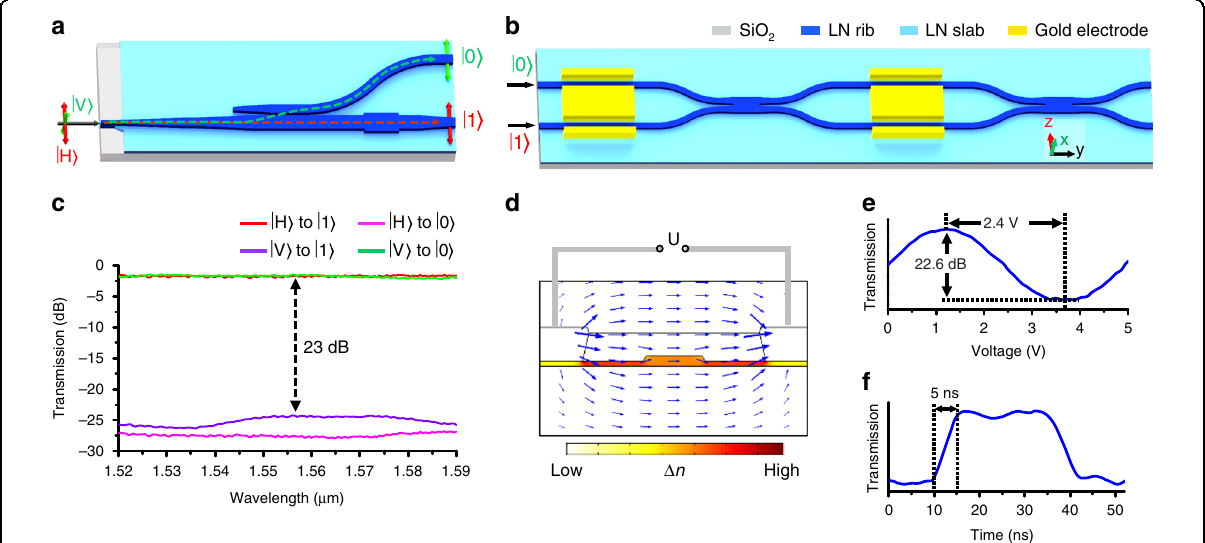
Fig. 1 Architecture and performance of the fundamental building blocks. a The schematics of the polarization splitter and rotator (PSR). V j i and H j i represent the vertically and horizontally polarized components of light in free space, respectively. 0 j i and 1 j i represent fundamental TE modes of upper and lower waveguides, respectively. b The architecture of 2 × 2 Mach-Zehnder interferometer (MZI), composed of two electro-optic (EO) phase shifters. c The measured transmissions of the fabricated PSR (including the off-chip coupling loss) when injecting horizontal polarization H j i and vertical polarization V j i , respectively. d The numerical result of the refractive index variation distribution of the lithium niobate (LN) waveguide when applying the voltage to the electrode. e The normalized transmission of a MZI as a function of an applied voltage, showing a half-wave voltage of 2.4 V and an extinction ratio of 22.6 dB. f The normalized transmission of a MZI as a function of time when applying rectangle wave signals,